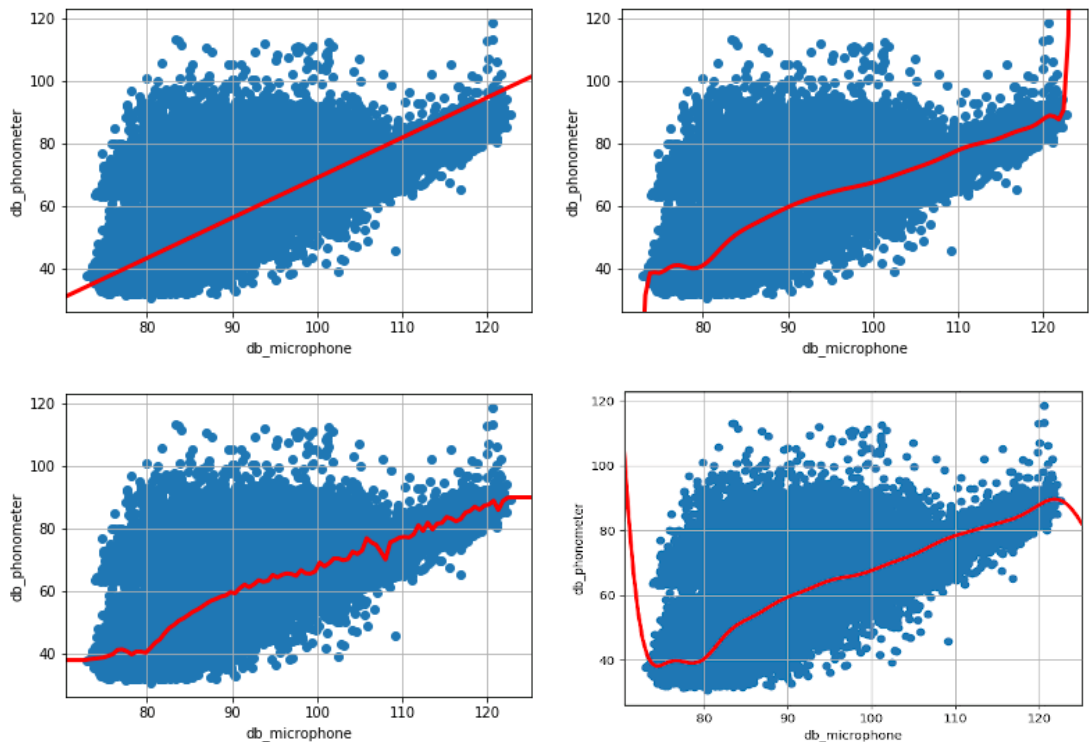
Figure 4. All the images show the correlation between the DtbC dB and RSlm dB. The top left image shows the univariate linear model, the top right image instead shows the polynomial model, the bottom left image the model based on Random forest and the bottom right image the model based on Support Vector